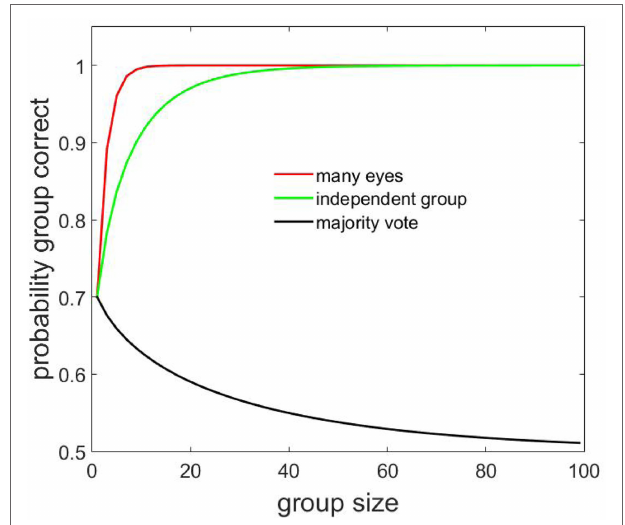
FIGURE 3 | Following the informed minority vs. majority voting. The red curve plots the percent of correct threat assessment as a function of group size for the optimal detection (many eyes) model, where even detection by a single individual can trigger a collective response. The black curve illustrates how performance would change with group size if animals used the majority vote. The green curve plots the performance of a crowd of independent individuals with same individual competence as for the many-eyes model. See main text for details and Appendix A2 for the mathematical derivation of the three lines.